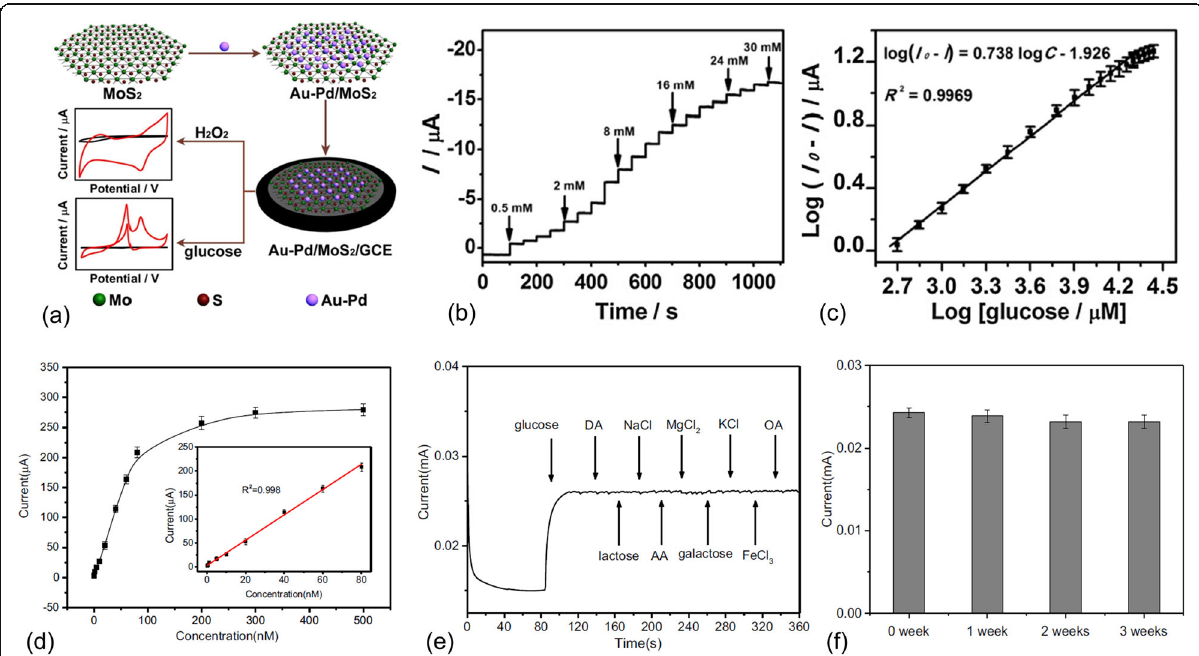
Fig. 3 a Illustration of the synthesis of Au-Pd/MoS 2 nanocomposites and assembly on a glassy carbon electrode for non-enzymatic electrochemical sensing of H 2 O 2 and glucose. b Amperometric responses of the Au-Pd/MoS 2 nanocomposite sensor to the successive addition of glucose. c The extracted response current to different glucose concentrations. Reprinted from [5], Copyright 2017, with permission from